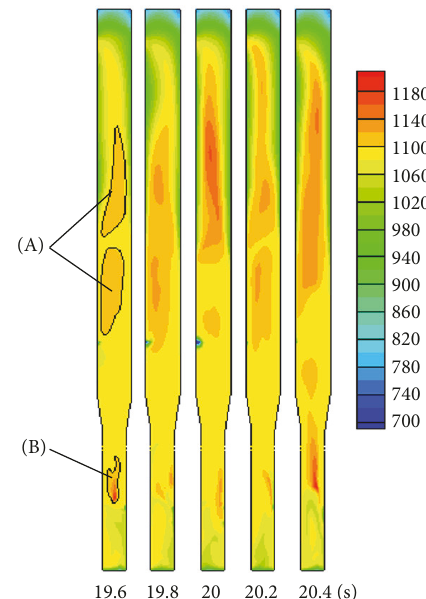
Figure 8: The contours of the instantaneous temperature distribu- tion of gas during 19.5-20.5 s (K). Region (A): the high temperature region above the secondary air inlet due to the volatile reburning. Region (B): the high temperature region above the fuel inlet due to the volatile